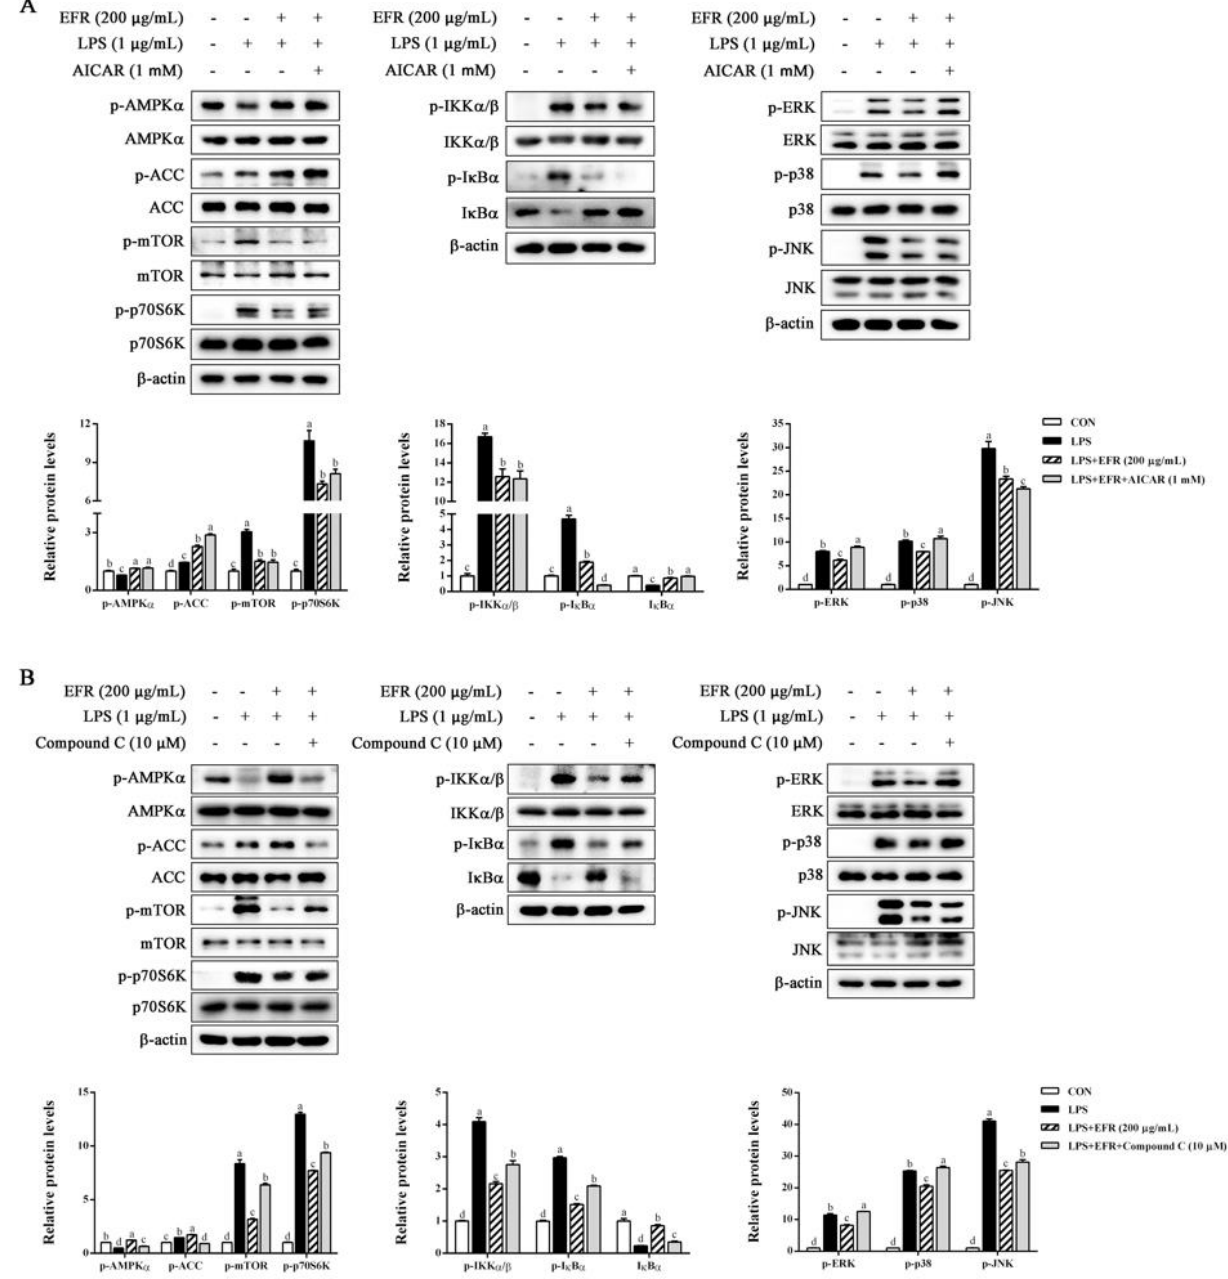
Figure 6 . The role of AMPK activation in the EFR-mediated anti-inflammatory effect in LPS-stimulated RAW 264.7 macrophages. ( A ) RAW 264.7 macrophages were pretreated with or without AICAR (1 mM) for 2 h, then with or without EFR (200 μg/mL) for 2 h and stimulated with or without LPS (1 μg/mL) for 30 min. Th e protein levels of AMPK, NF- κB, and MAPK signaling pathways were determined by Western blot analysis. β -actin was used as an endogenous control. ( B ) RAW 264.7 macrophages were pretreated with or without Compound C (10 μM) for 2 h, then with or without EFR (200 μg/mL) for 2 h and stimulated with or without LPS (1 μg/mL) for 30 min. The protein levels of AMPK, NF- κB, and MAPK signaling pathways were determined by Western blot analysis. β -actin was used as an endogenous control. Relative intensity of the immunoreactive bands was analyzed using the Image J software. Results are shown as the mean ± SD of three independent experiments. The different letters represent the statistical differences at p < 0.05 among the groups by Duncan’s multiple range test.